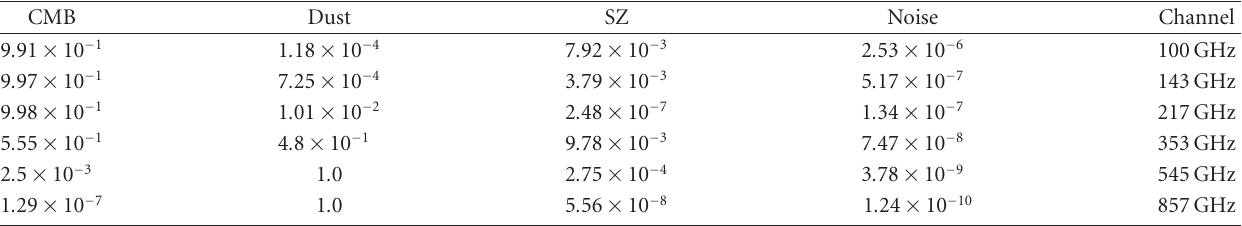
Table 2: Energy fraction contributed by each source to the total energy of each mixture, for the nominal noise variance on the Planck HFI